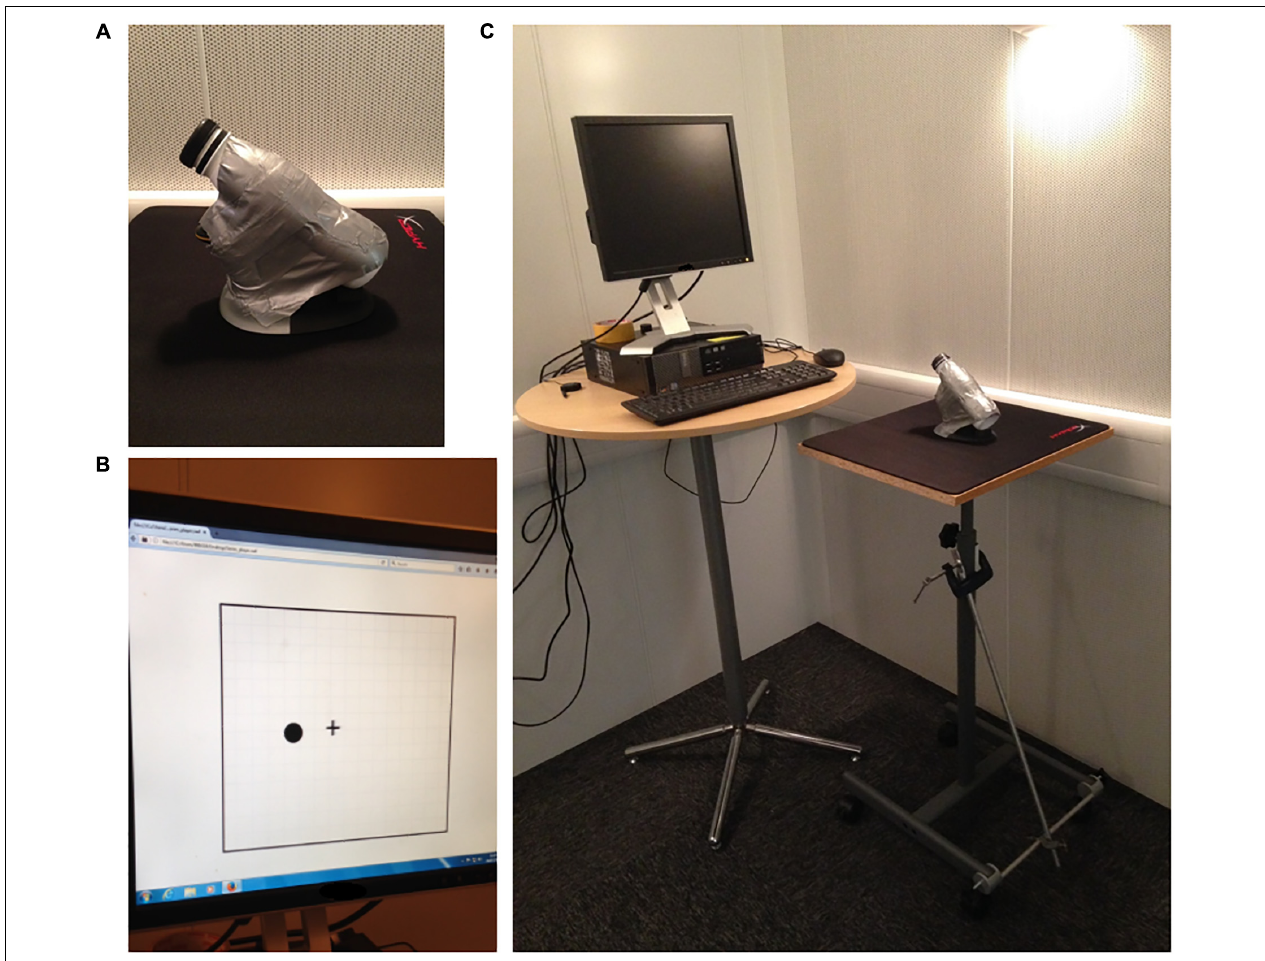
FIGURE 1 | The adapted vertical mouse that had to be controlled by participants while performing the computer-based motor task during Studies 1 and 2 (A) , what the task consisted in (B) , and the experimental setup for Studies 1 and 2 (C)